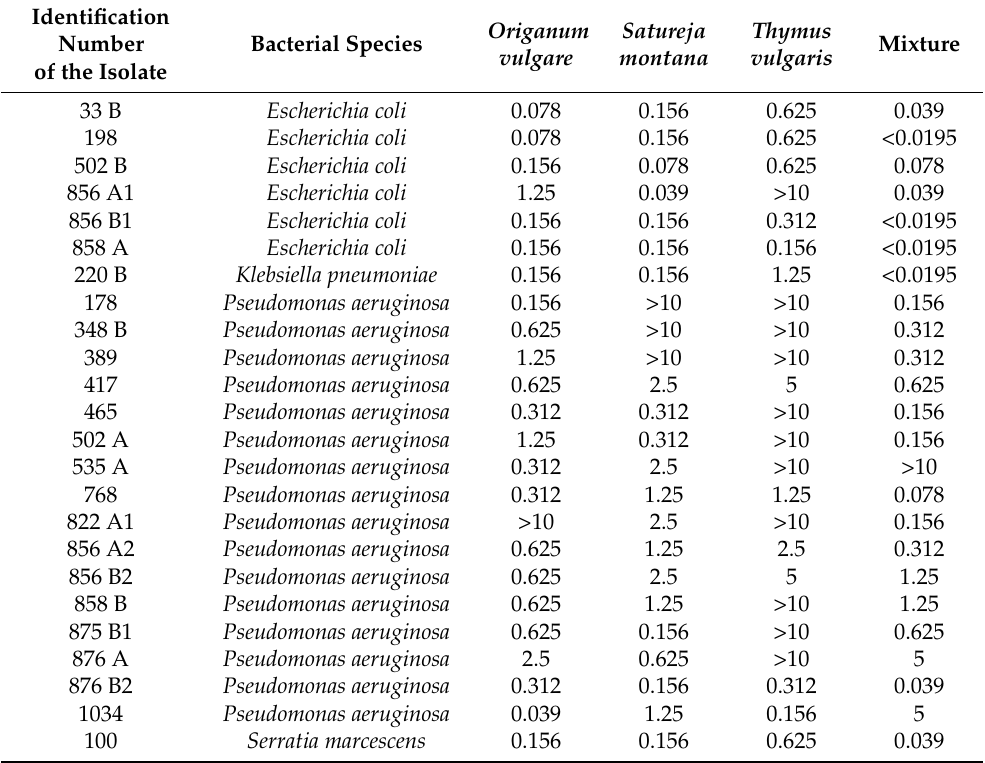
Table 3. MIC values of the tested EOs and mixture expressed in percentage ( v / v ) against the selected Gram-negative isolates.